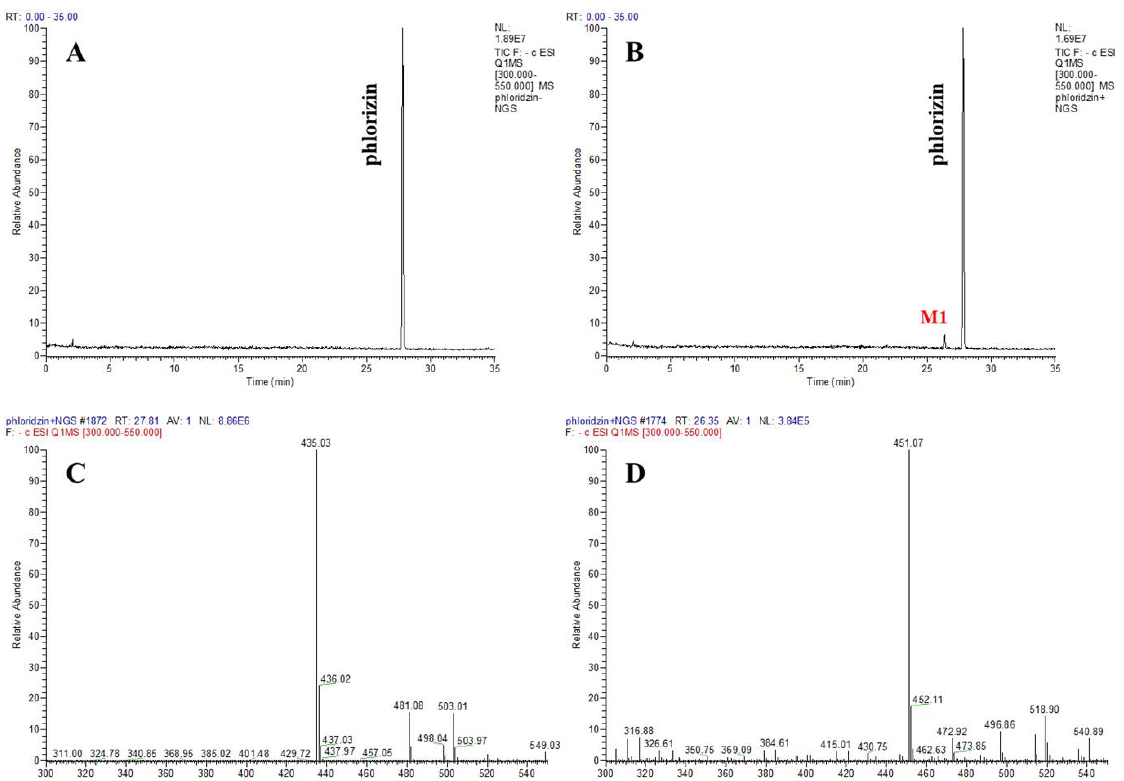
Figure 4. LC–MS analysis of phlorizin and its products produced by CYP102A1 M371 mutant. TIC